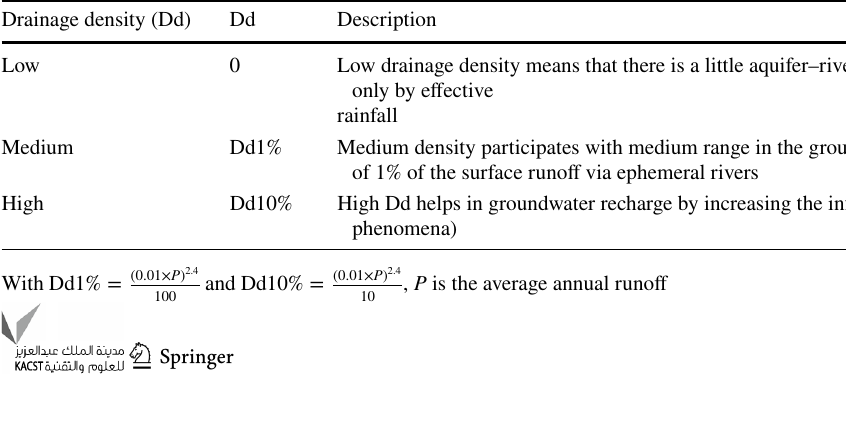
Table 4 Drainage density